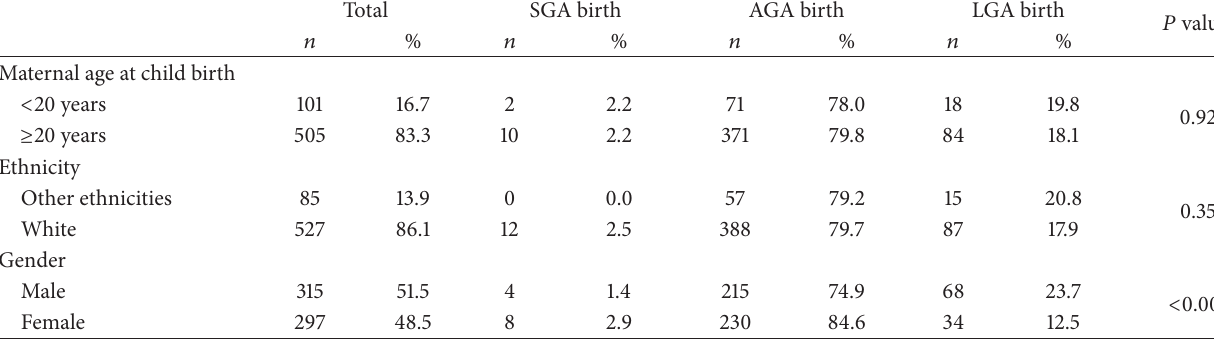
Table 1: Birth weight, maternal characteristics, and gender in Brazilian school children ( 𝑛 = 612), 2013. Total